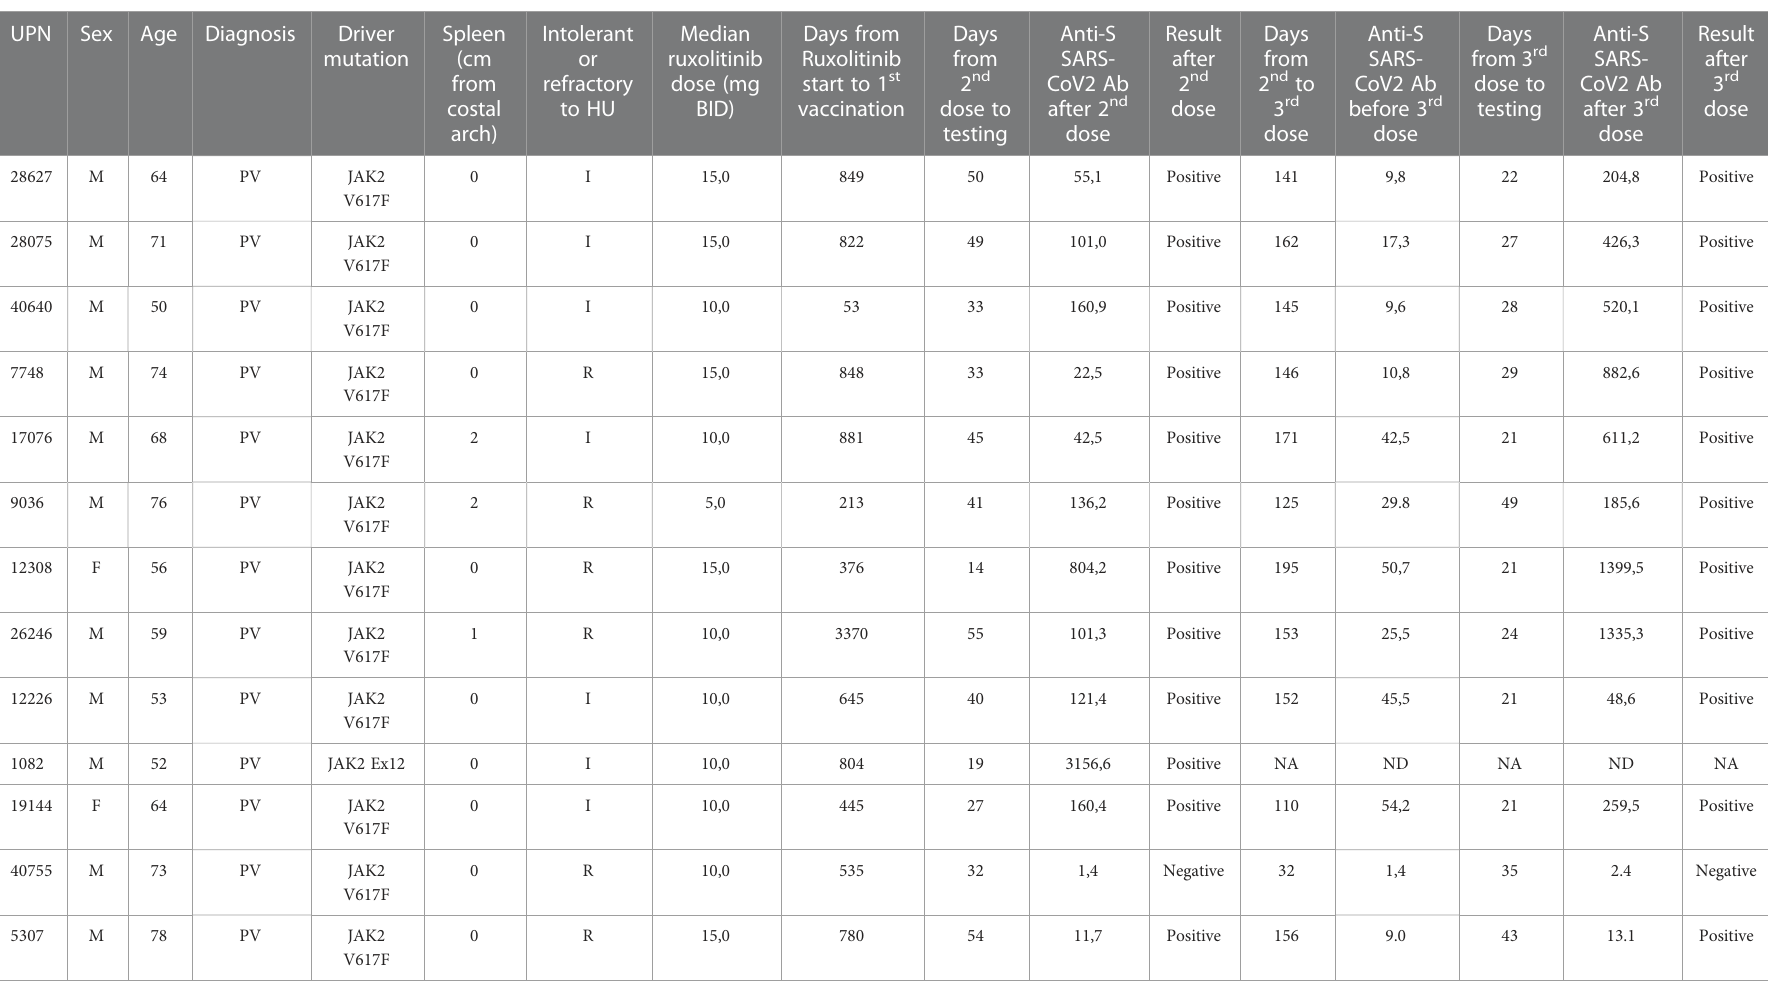
TABLE 2 Antibody level against SARS-CoV-2 N- and S-proteins in polycythemia vera patients.